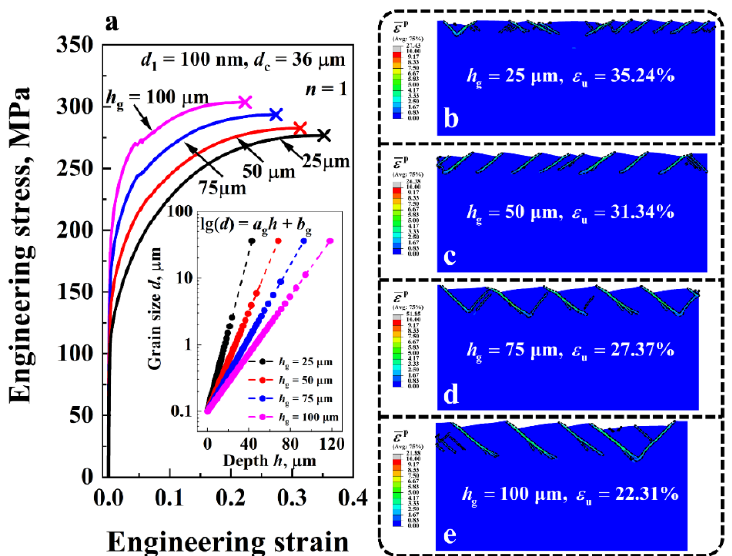
Figure 9. ( a ) Engineering stress-strain curves of the gradient Cu with different GSL thickness h g ranging from 43 µ m to 118 µ m. Variations of the grain size d along the thickness direction of the material under different h g are shown in the inset. ( b – e ) Comparison of the shear band patterns of the gradient Cu with different h g at the uniform elongation ε u . Regions where the equivalent plastic strain ε p was larger than 1 are enclosed by black dashed lines.